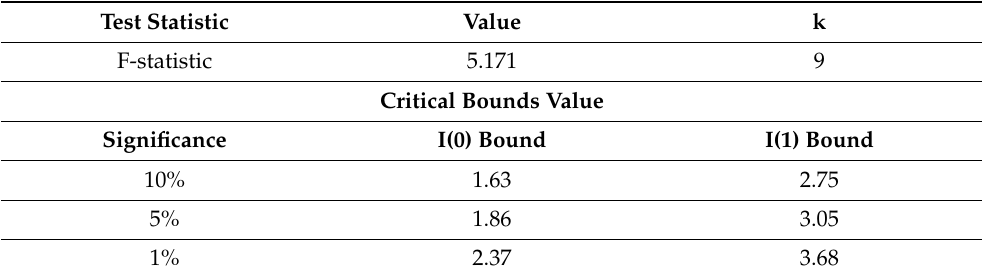
Table 7. ARDL Bounds Estimates.